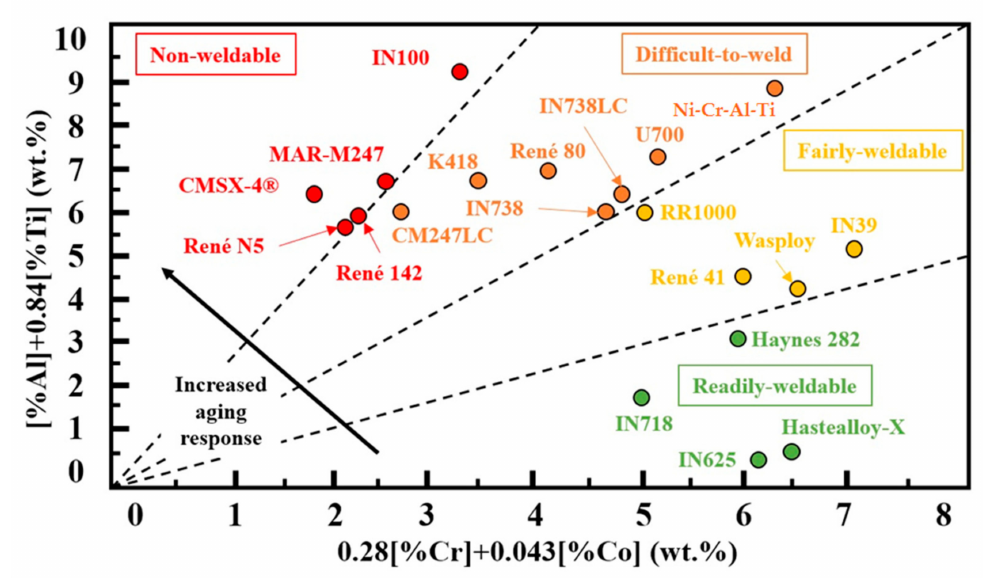
Figure 1. Weldability assessment for nickel-based superalloys